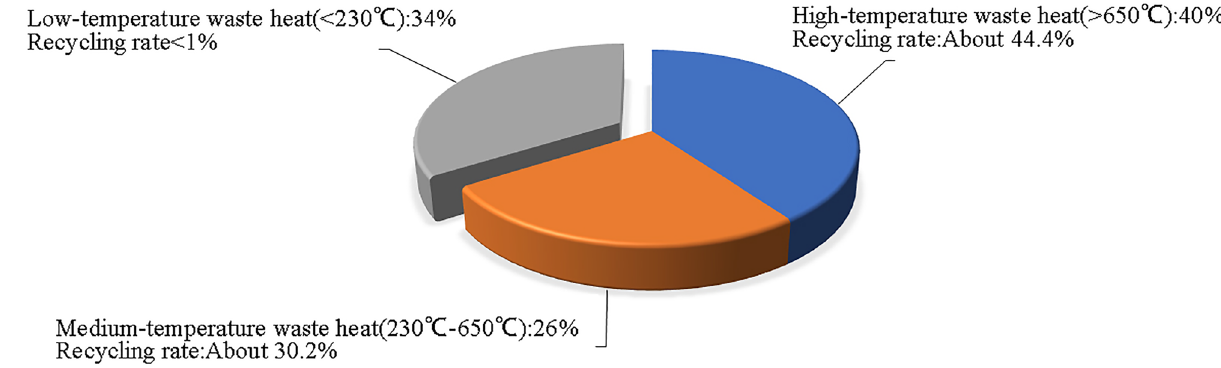
Figure 1. Distribution and reuse of waste heat